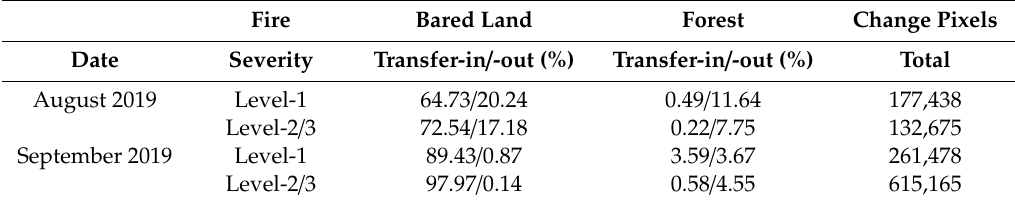
Table 5. Fire severity and the conversion of non-wetland types. Note: Statistical change pixels include those of the wetland and non-wetland types in the study